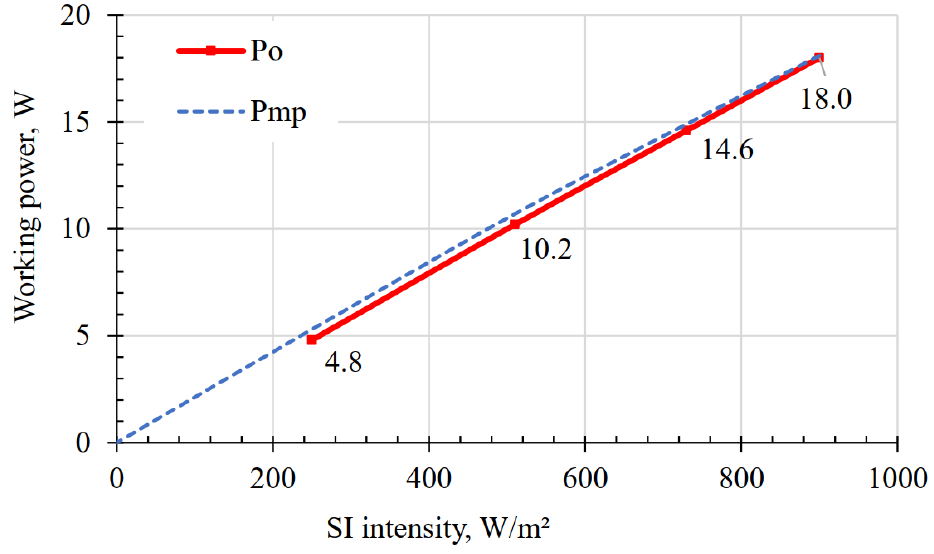
Figure 12. Indicators of the power taken from the PVM in operation, relative to its power by VWC at different solar radiation intensities: (P o ) indicators of the power of PVM in operation; (P mp ) power of PVM at the points of maximum